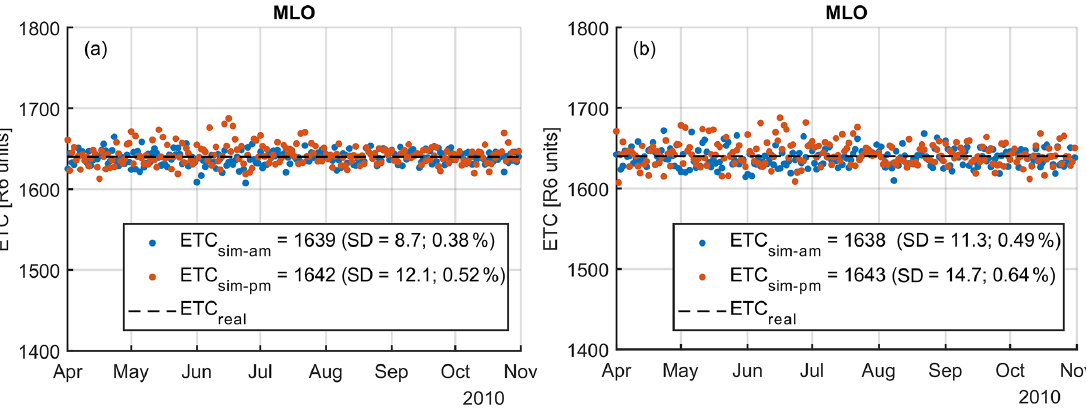
Figure 4. ETC responses to short-term ozone variations for MLO site (from April–October) simulated from MERRA-2 data. Blue and red dots are simulated individual ETCs (for morning and afternoon sessions, respectively) that would be obtained by a dummy Brewer (with known ETC real as 1640, indicated as the dashed black line), with TCO conditions provided by MERRA-2. Panel (a) is the model simulation without instrumental random noise, and panel (b) is the simulation with random noise. The mean and 1 σ values are shown in the legend. The percentage values are the 1 σ value corresponded % of TCO changes, in typical conditions ( (cid:127) = 280DU, (cid:49)α = 0 . 34, and µ =